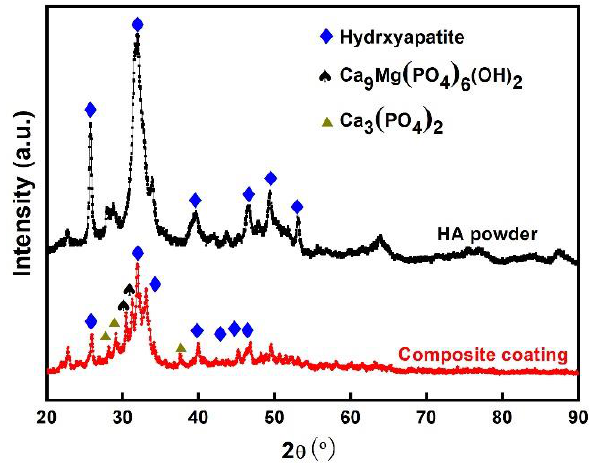
Figure 5. XRD patterns of composite coating and original HA powder.